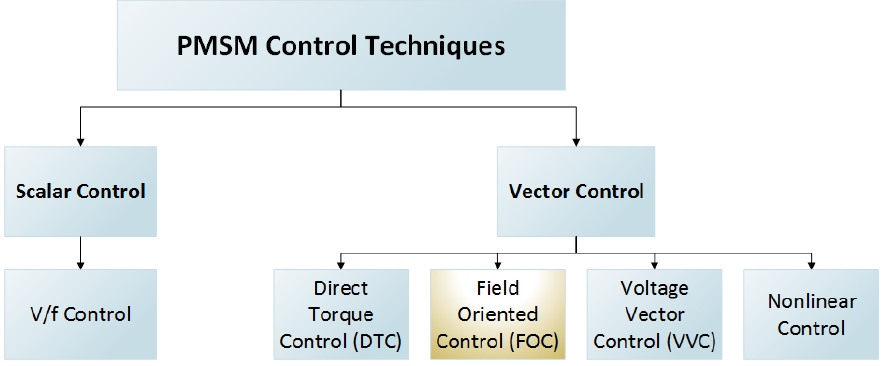
Figure 1. PMSM control techniques